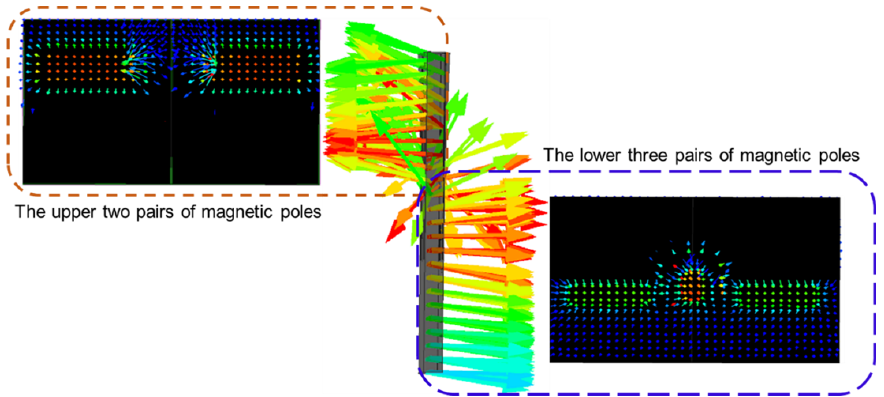
Figure 6. Funnel mold electromagnetic field vector diagram.